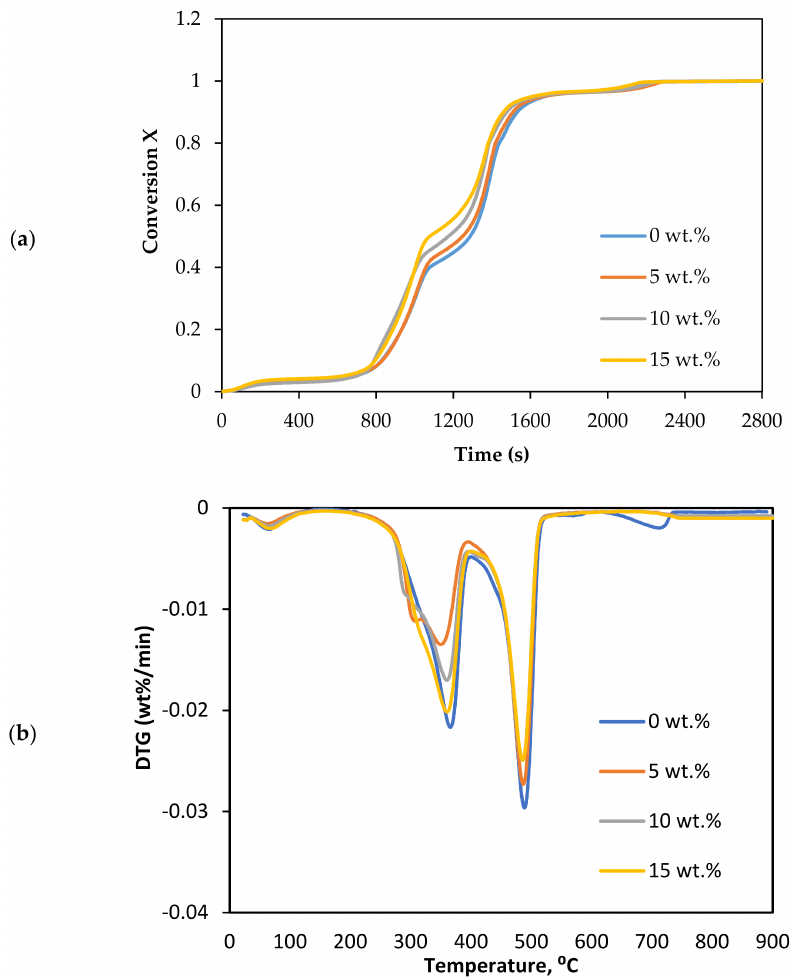
Figure 4. Effect of olivine loadings on the CO 2 gasification: ( a ) conversion degree, and ( b ) DTG curves.